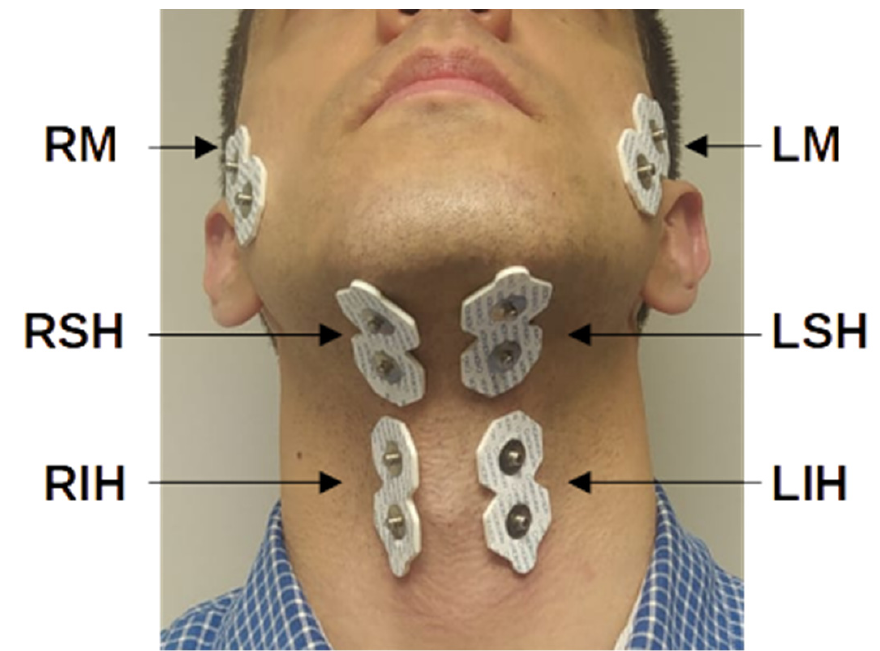
Figure 1. Electrode placement configuration for acquisition of multichannel sEMG signals. RM and LM: right and left masseter, respectively; RSH and LSH: right and left suprahyoid, respectively; RIH and LIH: right and left infrahyoid, respectively.